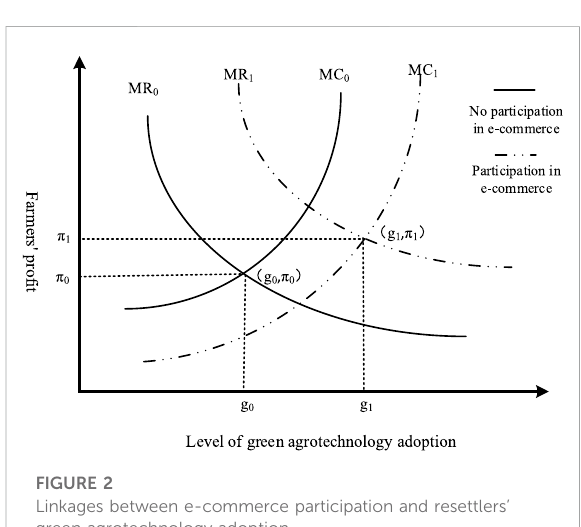
FIGURE 2 Linkages between e-commerce participation and resettlers ’ green agrotechnology